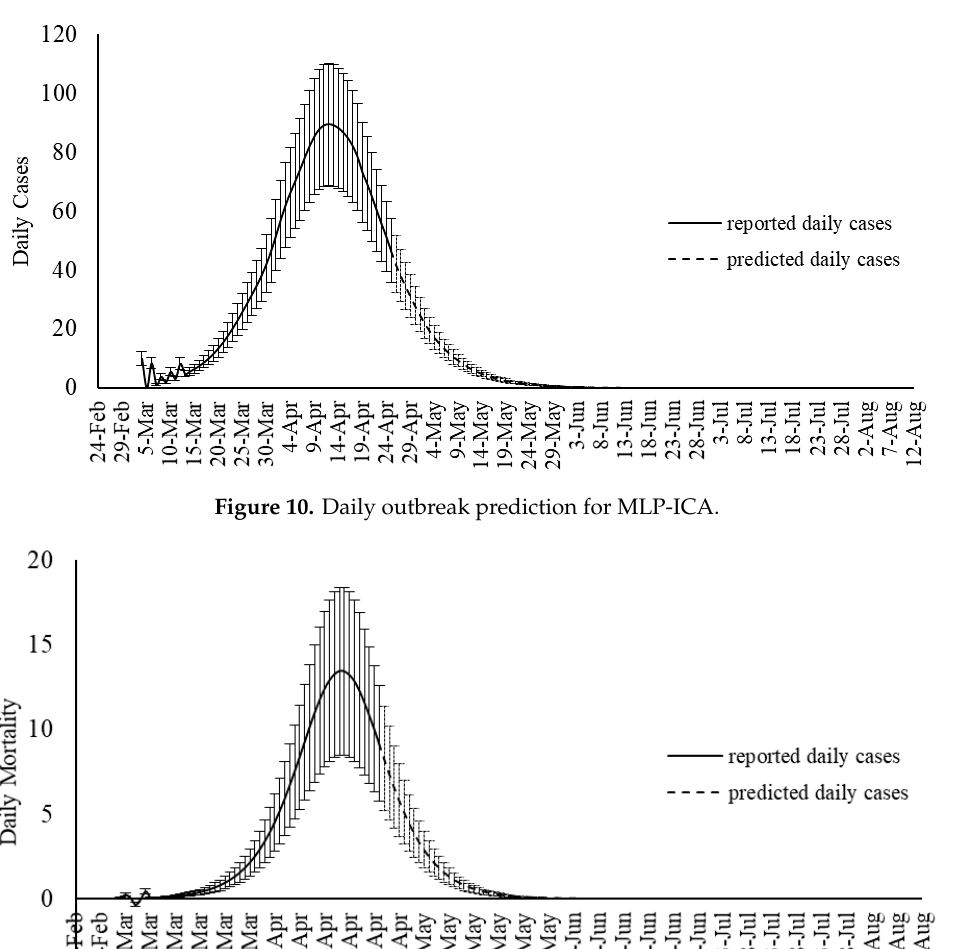
Figure 9. Total mortality rate prediction for MLP-ICA.